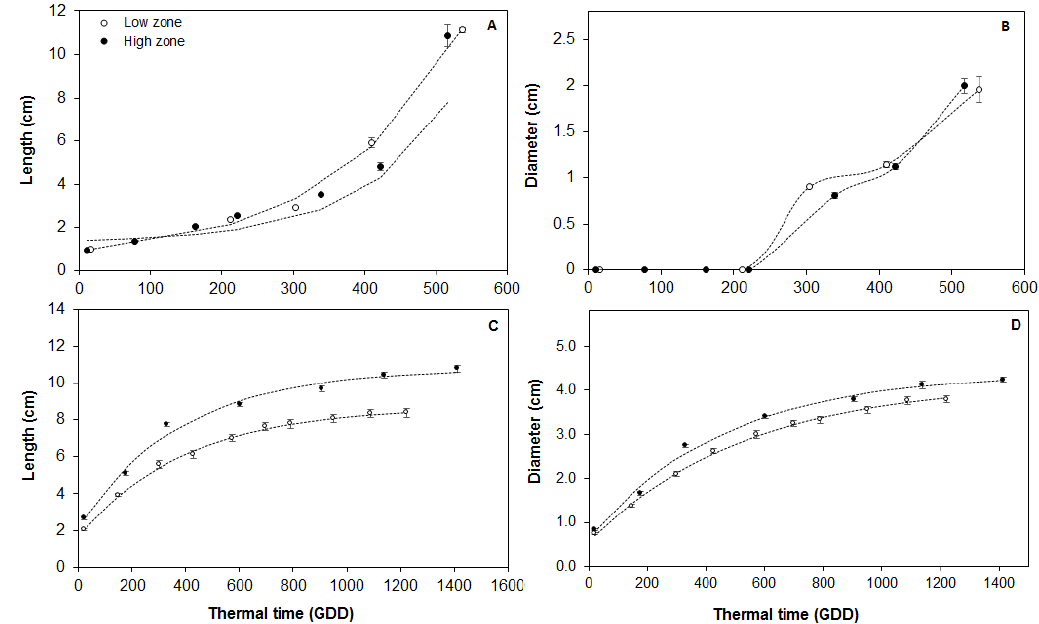
Fig. 3: Growth in length (A) and diameter (B) of flower buds; length (C) and diameter of fruits (D) as a function of the thermal time of P. tripartita var. mollissima in a high zone (2,498 m.a.s.l.) and a low zone (2,006 m.a.s.l.) in the municipality of Pasca (Cundinamarca, Colombia). The vertical bars indicate the standard error ( n =80 floral buds and n =40